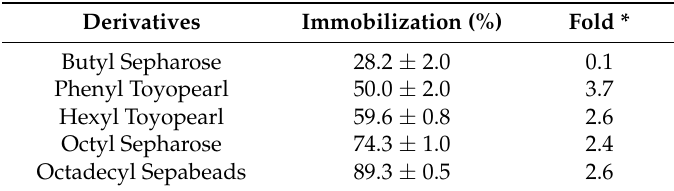
Table 1. Lipase immobilization on hydrophobic supports at pH